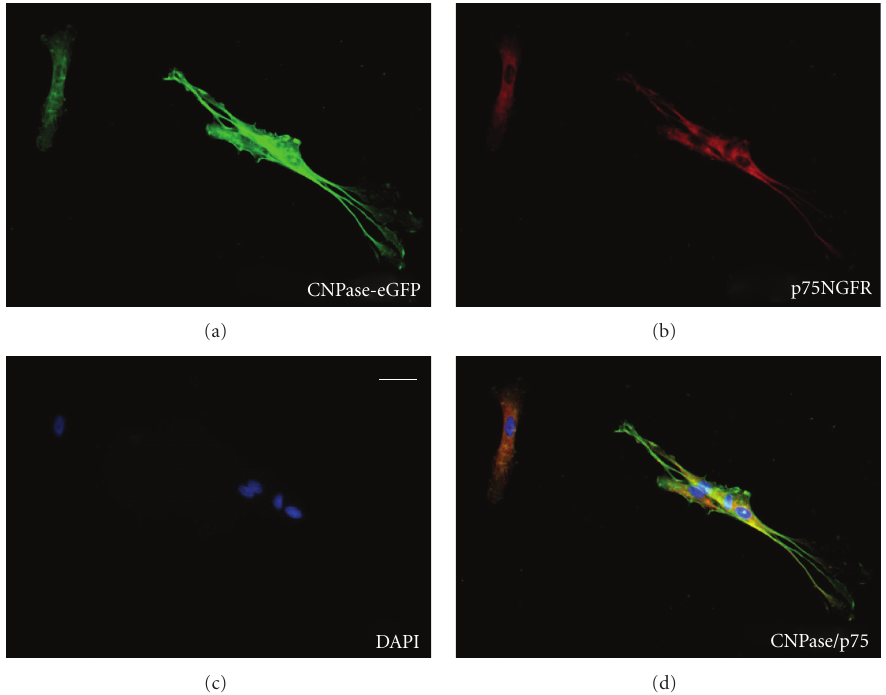
Figure 3: Cultured OECs from the CNPase transgenic mouse maintain their GFP expression. (a–d) Immunostaining of cultured olfactory bulb OECs derived from the eGFP-CNPase mouse indicates colocalization with p75. Nuclei stained blue with DAPI. Note the small cluster of spindle-shaped OECs and a more flattened OEC (upper left) both colocalize GFP (CNPase) and p75. Scale bar: (a) = 5 µ